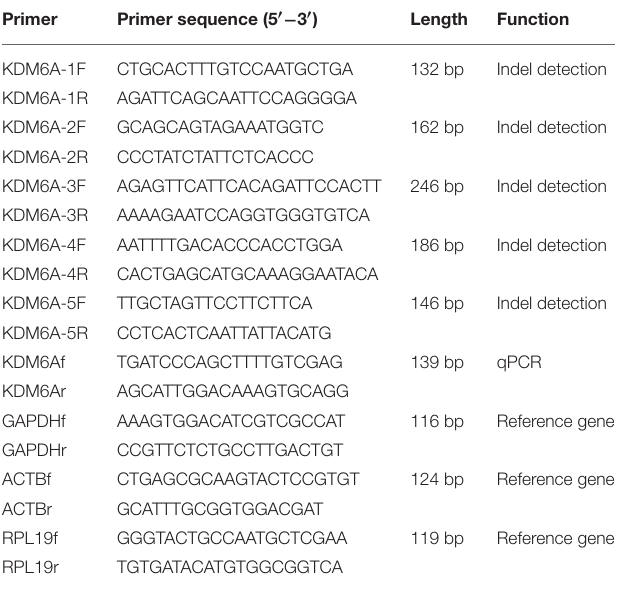
TABLE 1 | PCR primers used for detecting indel loci and qPCR analysis of goat KDM6A gene. Primer Primer sequence (5 ′ − 3 ′